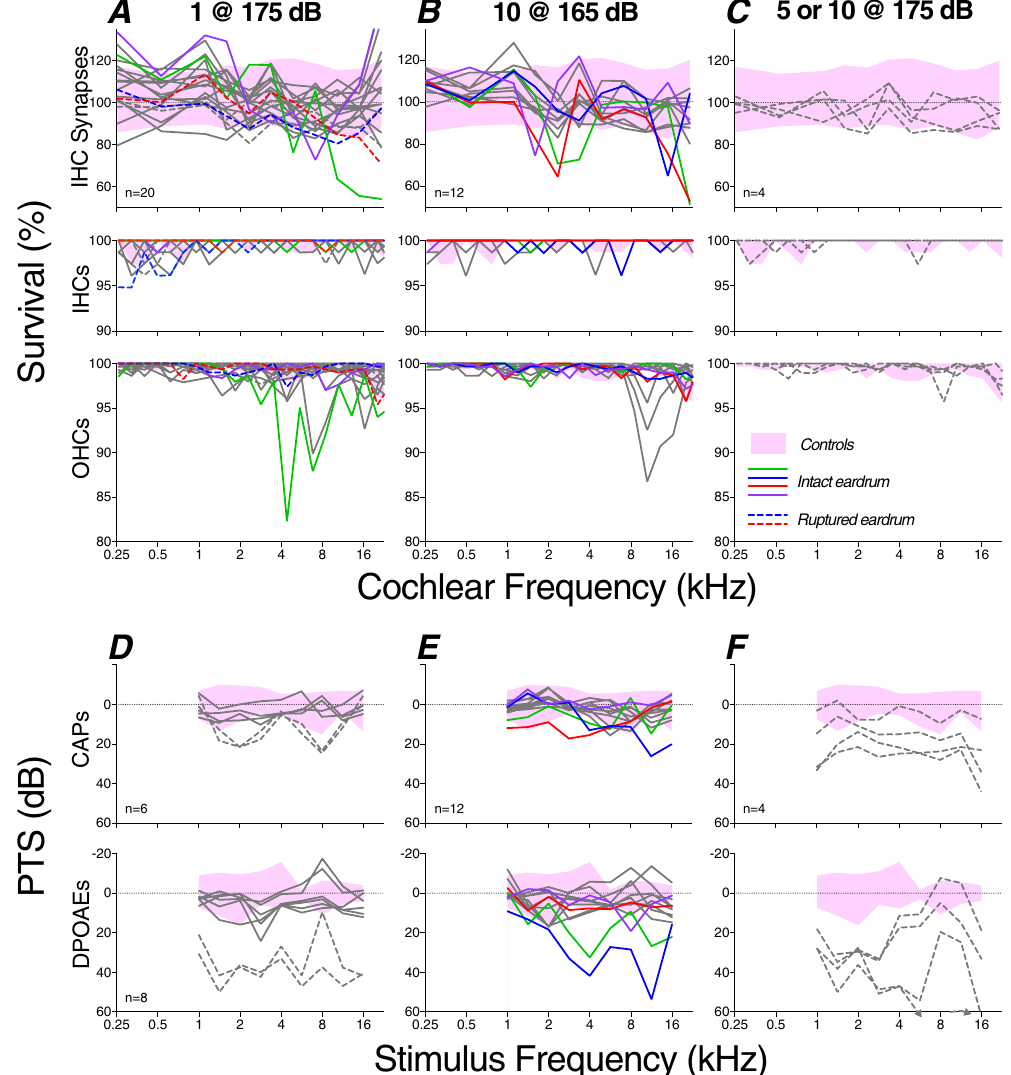
Figure 5. Summary histopathology ( A – C ) and pathophysiology ( D – F ) from blast groups exposed at the three higher SPLs and obtained 1 wk post exposure. Pink shading indicates the range of control values for each metric (see Fig. 4). Line colors are used to identify individual ears within each column, allowing direct comparison of pathophysiology and histopathology in the same ear. Cases with significant synaptopathy (i.e. fewer synapses than control mean by > 2 standard deviations) are shown with colored lines; grey lines are for cases without significant synaptopathy. Dashed lines are for cases with ruptured eardrum. The key in C applies to all panels. All data are normalized to control means. All other aspects of data acquisition are as described in the caption for Fig.